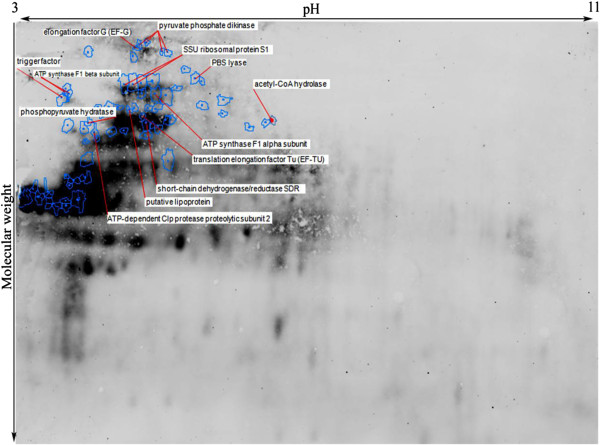
Identification of carbonylated proteins of freeze-dried A. senegalensis stored at 35°C after separation by 2D-electrophoresis. A preparative gel and a western blot gel containing the same sample were run in parallel. Anti-DNP antibody staining was realized on the WB to localizethe carbonylated proteins spots that were then reported on the preparative gel image, as indicated by the blue spots. Eighty-eight proteins which underwent carbonylation were then picked from the preparative gel and analyzed by mass spectroscopy. Thirteen different proteins were identified as indicated on the gel image, of which 10 are carbonylated proteins with modifications in Arginine, Lysine, Proline and Threonine as listed on Table 2.